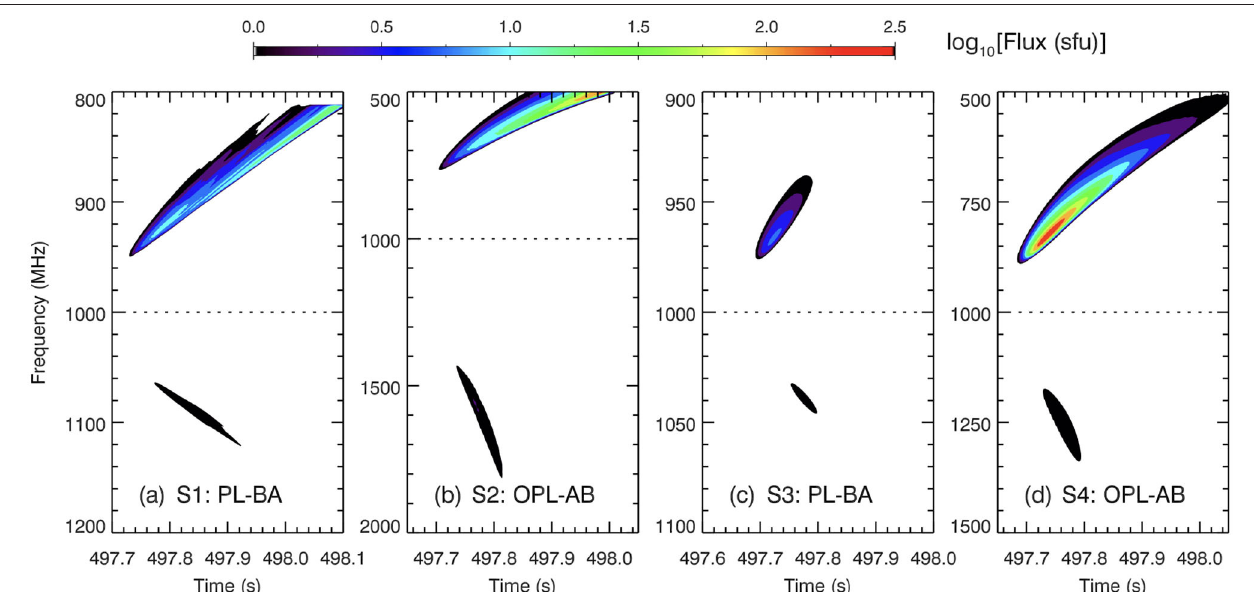
FIGURE 9 | Predicted type III second harmonic dynamic spectrum of a bi-directional electron beam injection using simulations with different ininital conditions. From Li et al.